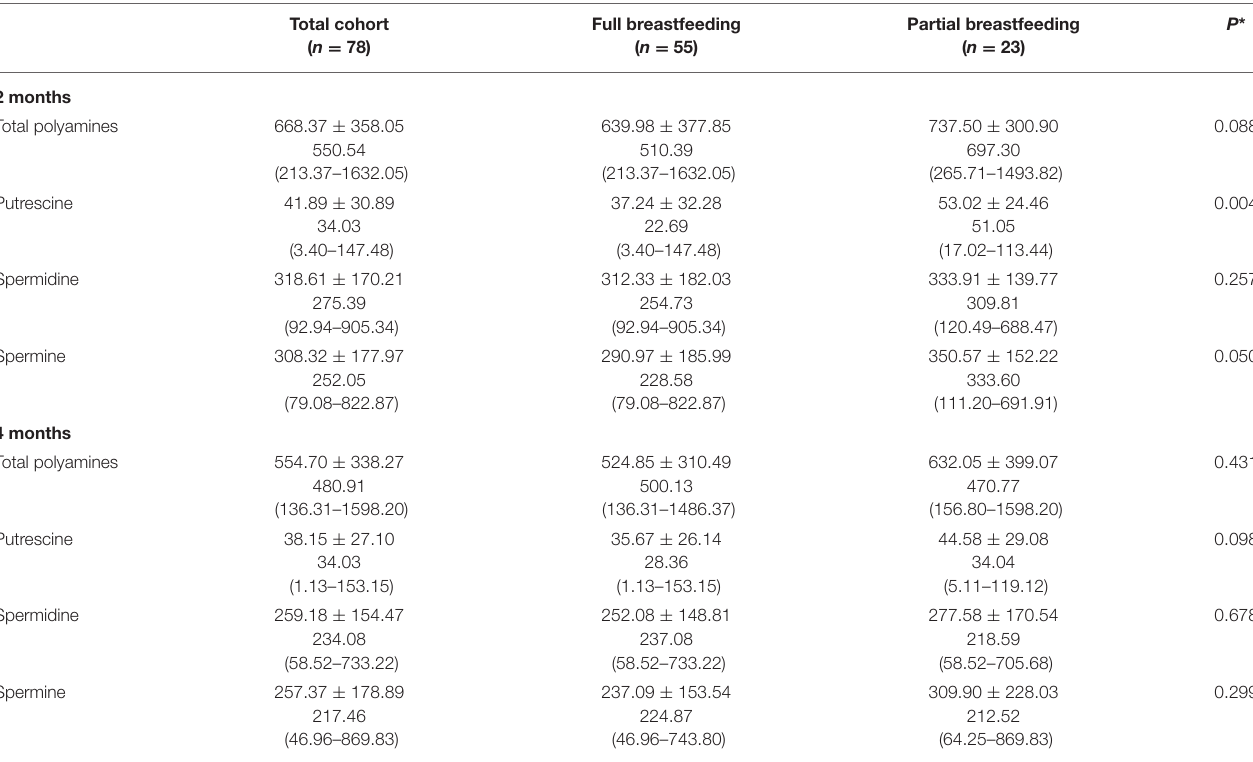
TABLE 2 | Polyamine content in human milk (nmol/dL) at 2 and 4 months in the total cohort and according to the type of breastfeeding (Mean ± SD, median, minimum, and maximum).